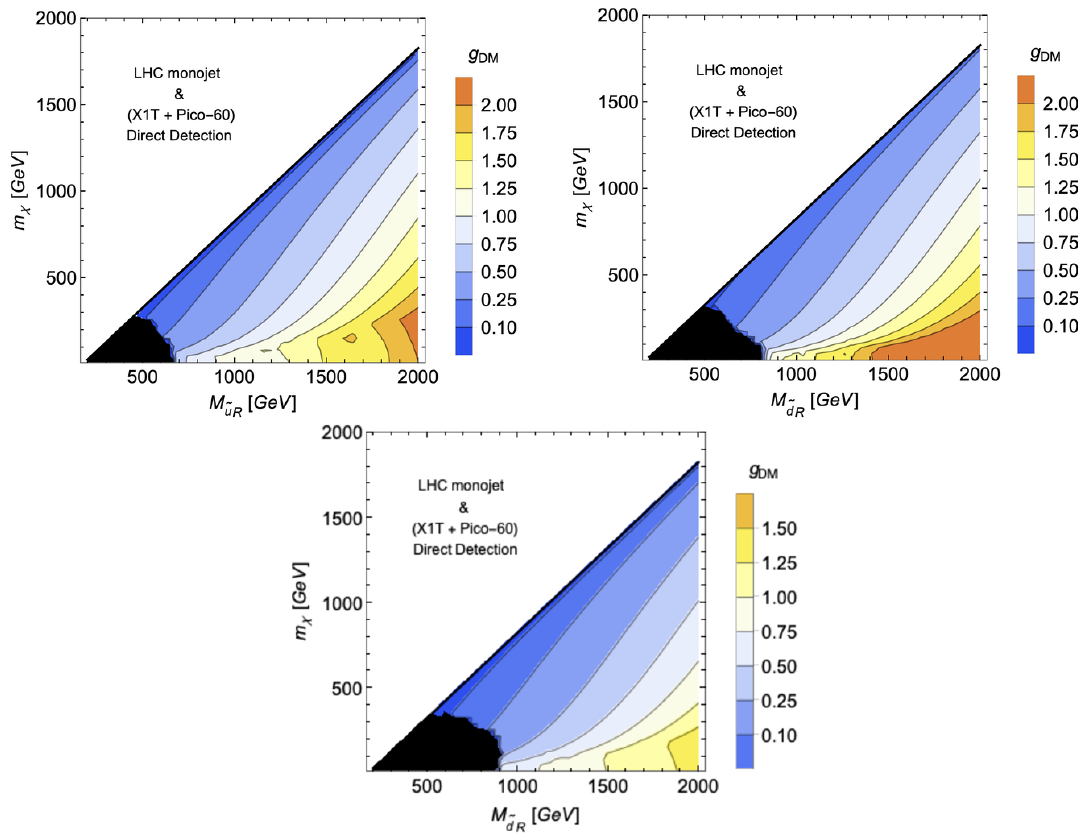
Figure 13 . Combined SI, SD and LHC constraints for the u R (upper left), d R (upper right) and q L (lower) models. Shaded regions indicate allowed values of the coupling g DM